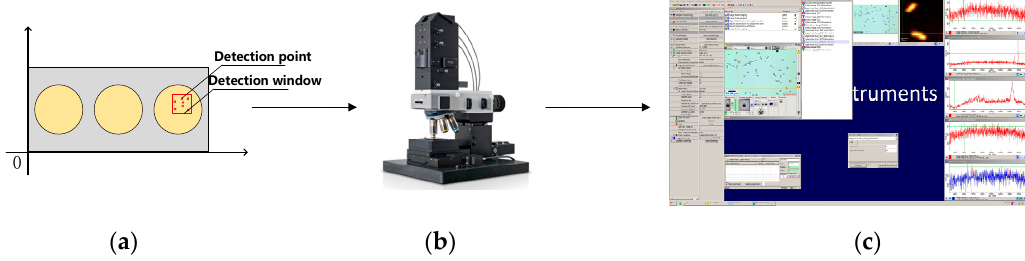
Figure 2. Acquisition of spectra by a Raman spectrometer. ( a ) The schematic of the determination of the detection points. ( b ) Spectral data acquisition. ( c ) Spectral analysis.